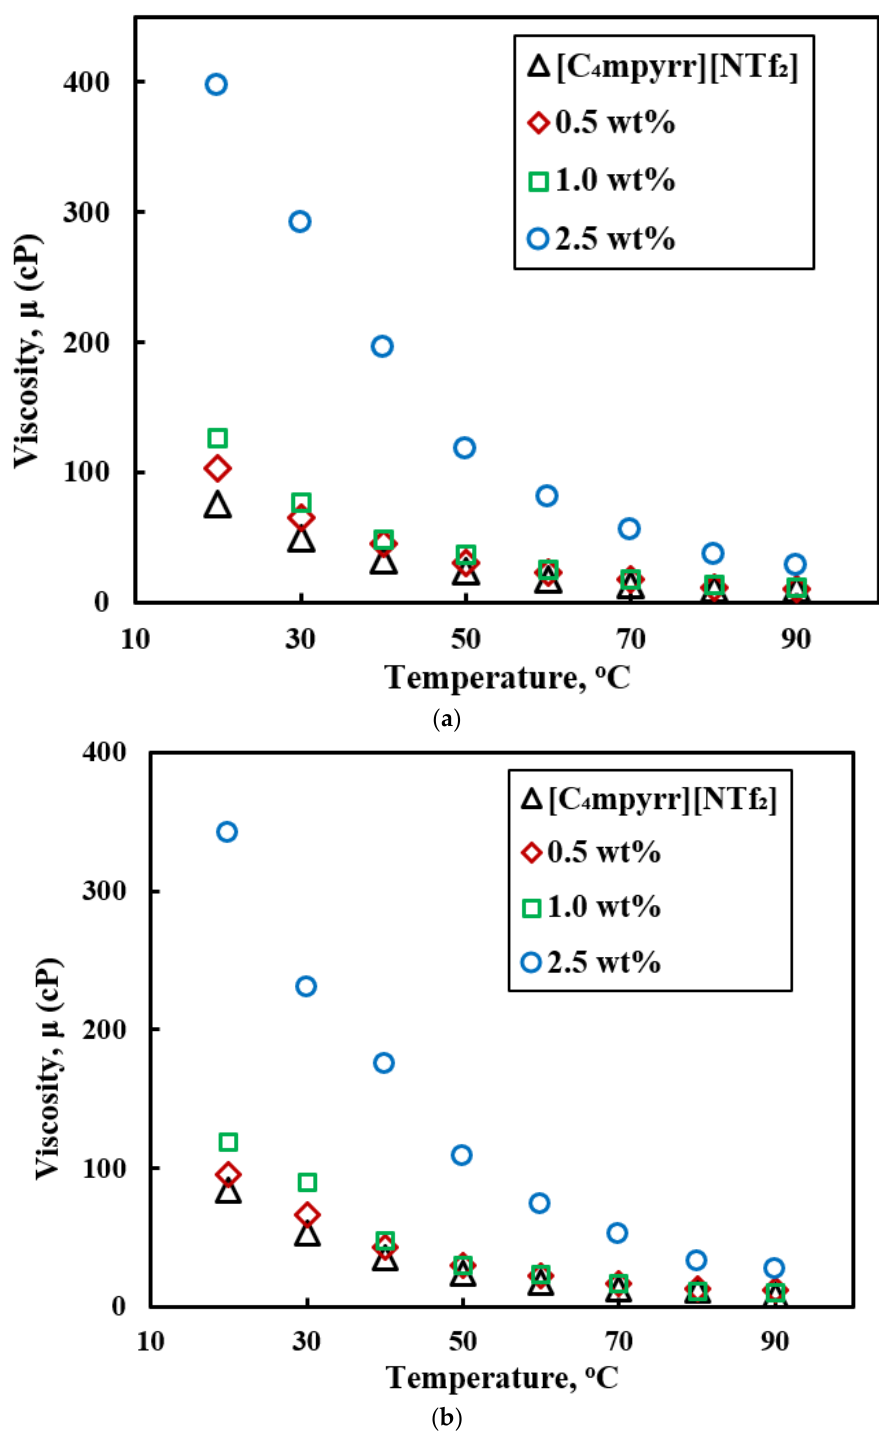
Figure 19. Effect of ( a ) spherical, and ( b ) whiskers shaped Al 2 O 3 nanoparticle on viscosity of [C 4 mpyrr][NTf 2 ] IL [84]. Reproduced with permission from [Paul], [Int. J. Heat Mass